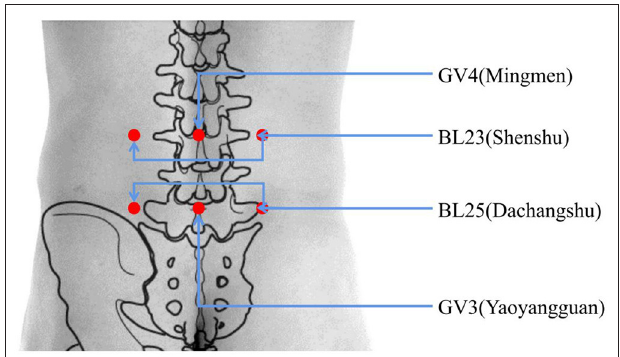
FIGURE 2 | Location of acupoints. BL25 (Dachangshu); under the spinous process of the fourth lumbar spine, with a side opening of 5cm. GV3 (Yaoyangguan); on the posterior midline, under the spinous process of the fourth lumbar spine. BL23 (Shenshu); under the spinous process of the second lumbar spine, with a side opening of 5cm. GV4 (Mingmen); on the posterior midline, under the spinous process of the second lumbar spine.